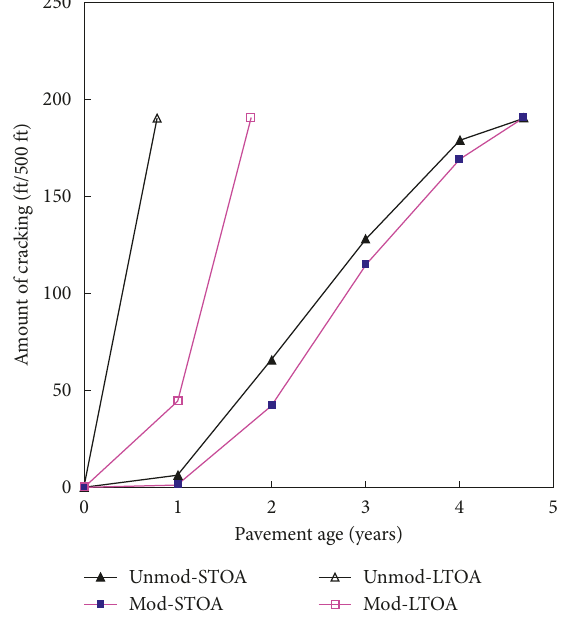
Figure 7: Effect of aging on thermal cracking of AOX-modified and unmodified asphalt mixtures (from Apeagyei